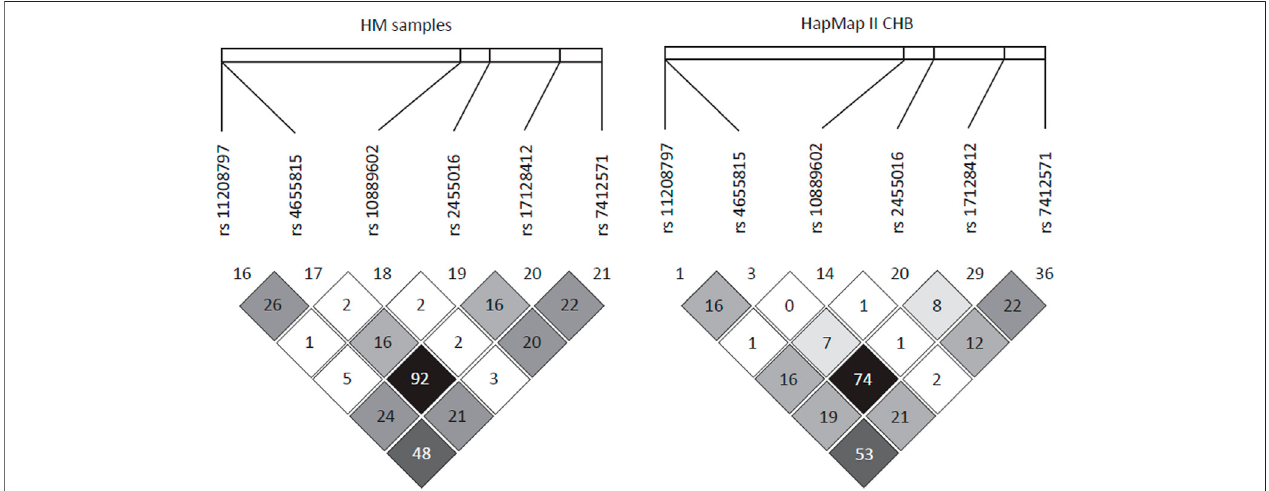
FIGURE 2 | Linkage disequilibrium pattern of the region neighboring rs10889602T/G. In a 30-kb region encompassing rs110889602T/G, there was a very low linkagedisequilibriumbetweenthislocusandsurroundingSNPsinoursamples( r 2 < 0.03,leftpanel)andinHanChineseinBeijing(CHB)samplesoftheHapMapproject ( r 2 < 0.02, right panel).